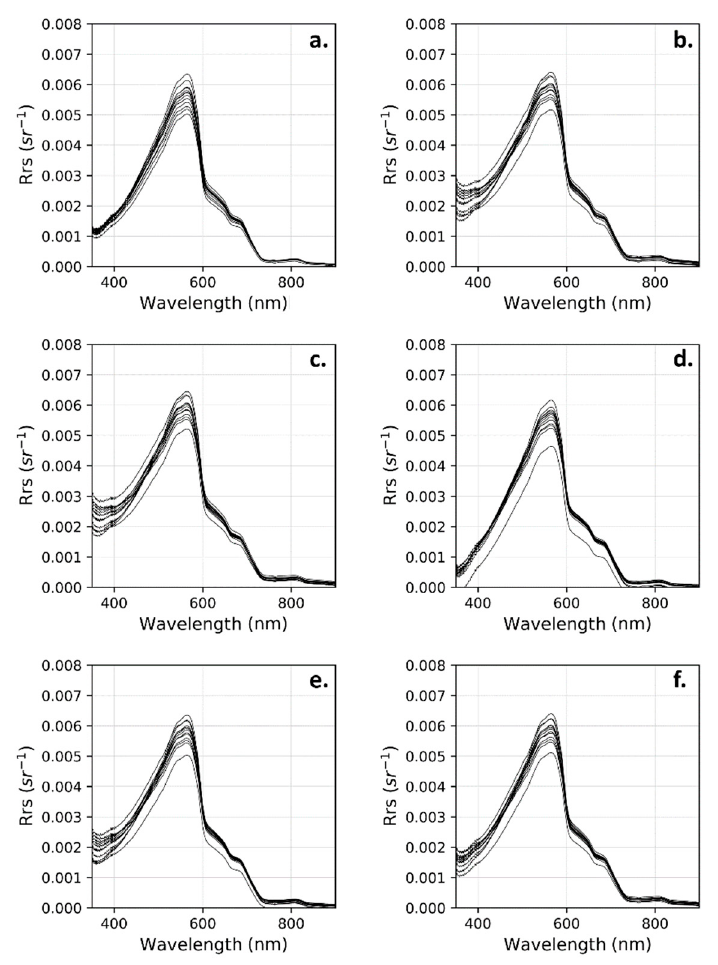
Figure 6. Reference R rs spectra obtained by each calculation method used. ( a ) 3C; ( b ) M99(1); ( c ) M99(2); ( d ) M15; ( e ) OSOAA(fine); ( f ) OSOAA(coarse). Each curve is the reference R rs of a day of measurement that corresponds to the best measurement acquisition conditions (relative azimuth > 90°, sun zenith angle < 50°, E d /cos θ > 1618 mWm − 2 nm − 1 , L d (550) < 0.15 mWm − 2 nm − 1 sr − 1